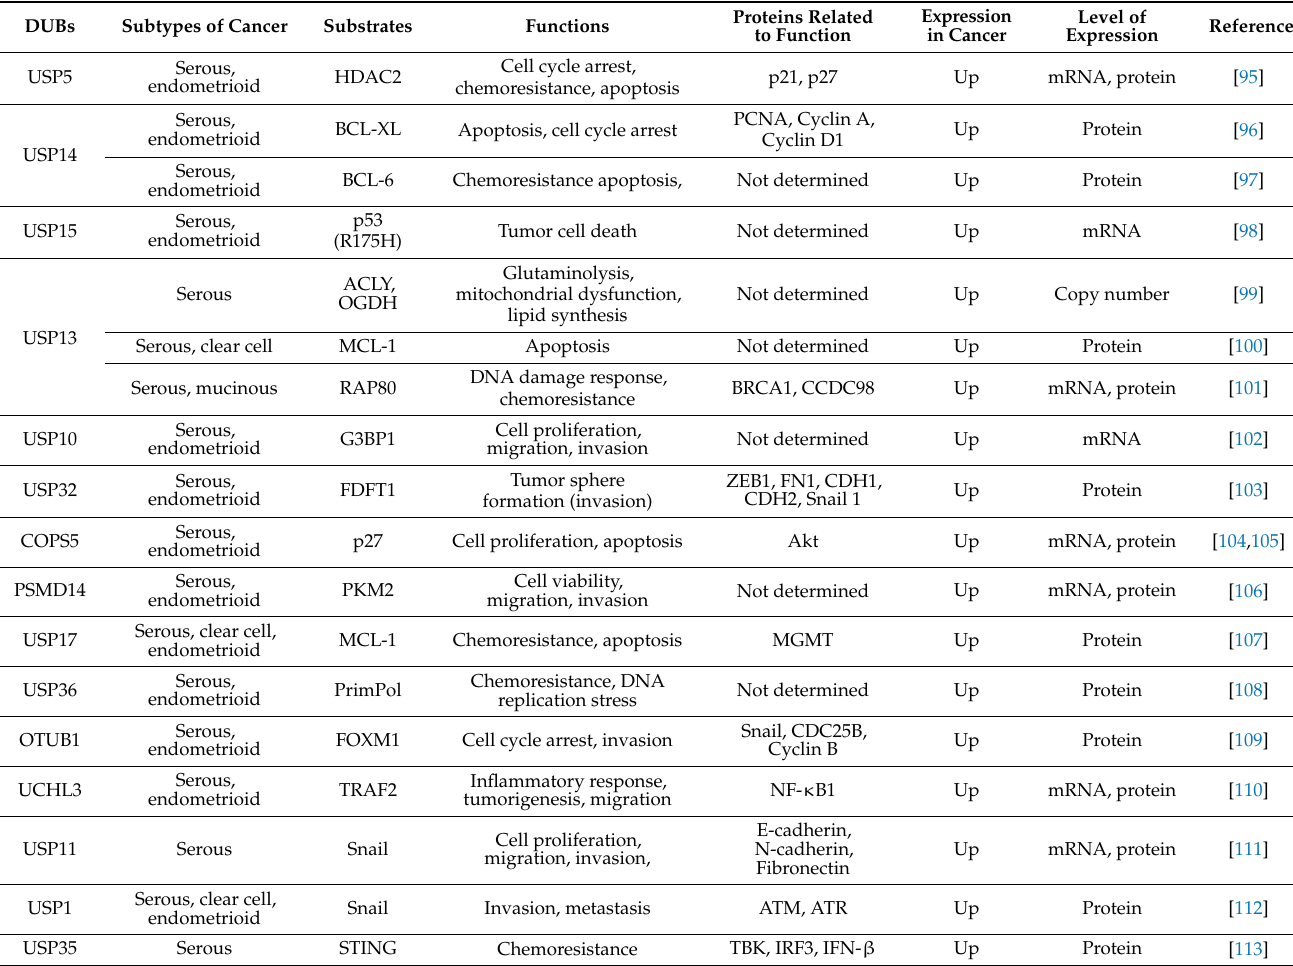
Table 2. List of DUBs, substrates, and functions which are associated with ovarian